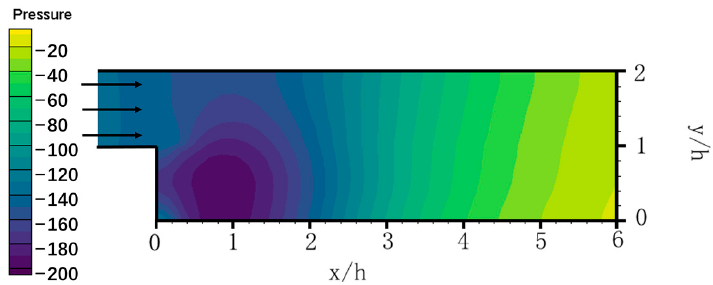
Figure 11. Pressure distribution when Re = 4000. Table 1. The minimum gauge pressure in the flow field of the back step under different Reynolds